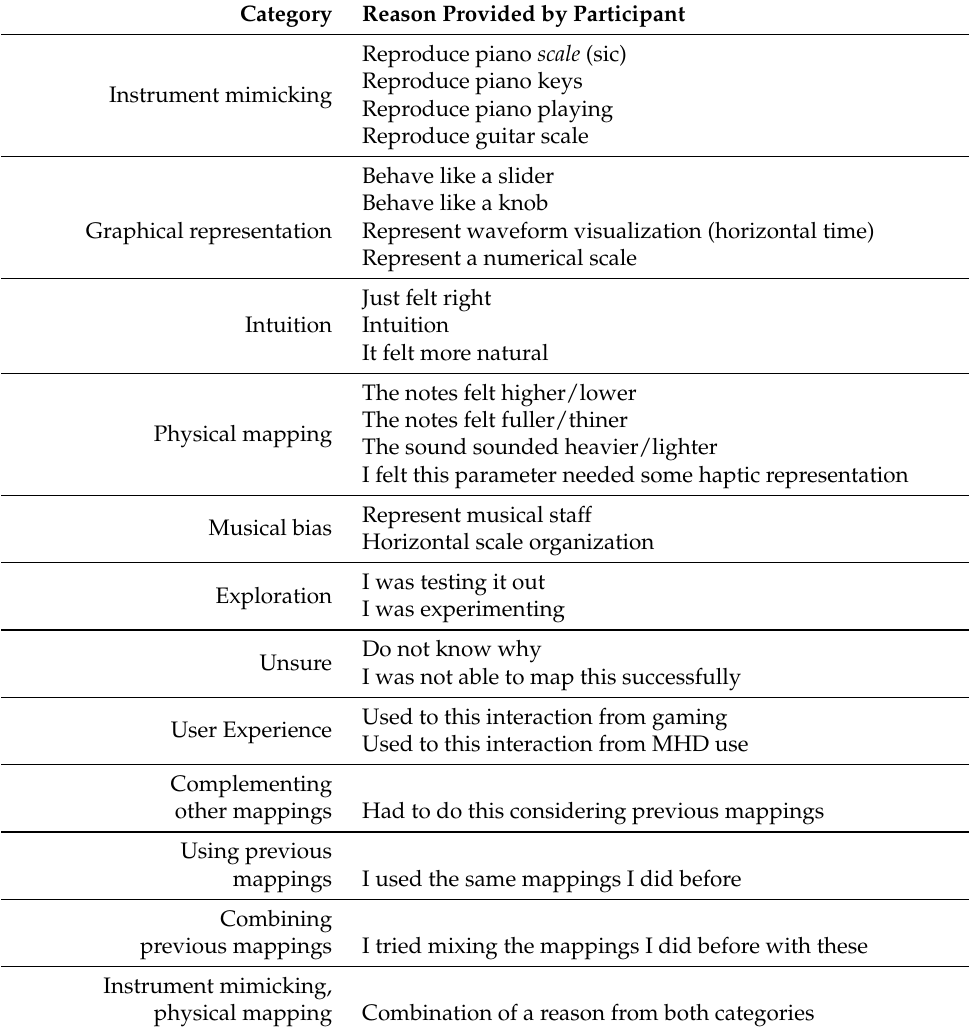
Table A2. Categorization of gesture choice